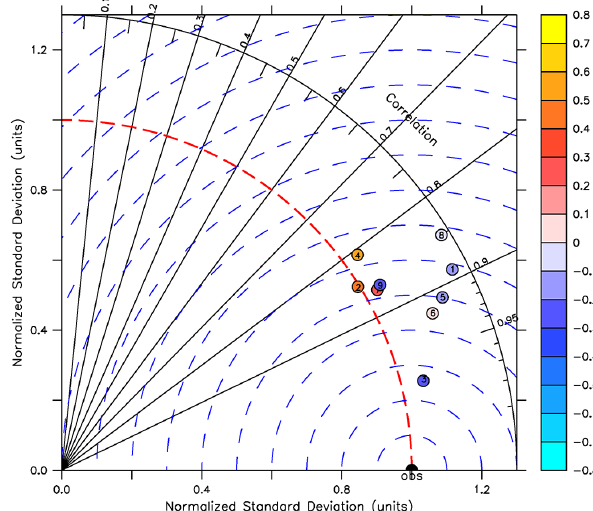
Figure 1. Taylor diagram of the comparison of the simulated fields with the observations for surface phosphate (1), dissolved oxygen at 500 m (2), surface aragonite saturation state (3), lysocline depth (4), and the three-dimensional fields of alkalinity (5), preindustrial dissolved inorganic carbon (6), dissolved oxygen (7), phosphate (8) and apparent oxygen utilisation (9). The observations are based on (Key et al., 2004) and (Boyer et al., 2009); the REF 1995 simulated fields are used for the comparison except for preindustrial inorganic carbon, which comes from the REF simulation in 1850. The colour bar gives the bias in the simulated fields normalised by the standard deviation in the observed fields. The plotted data are summarised in Table